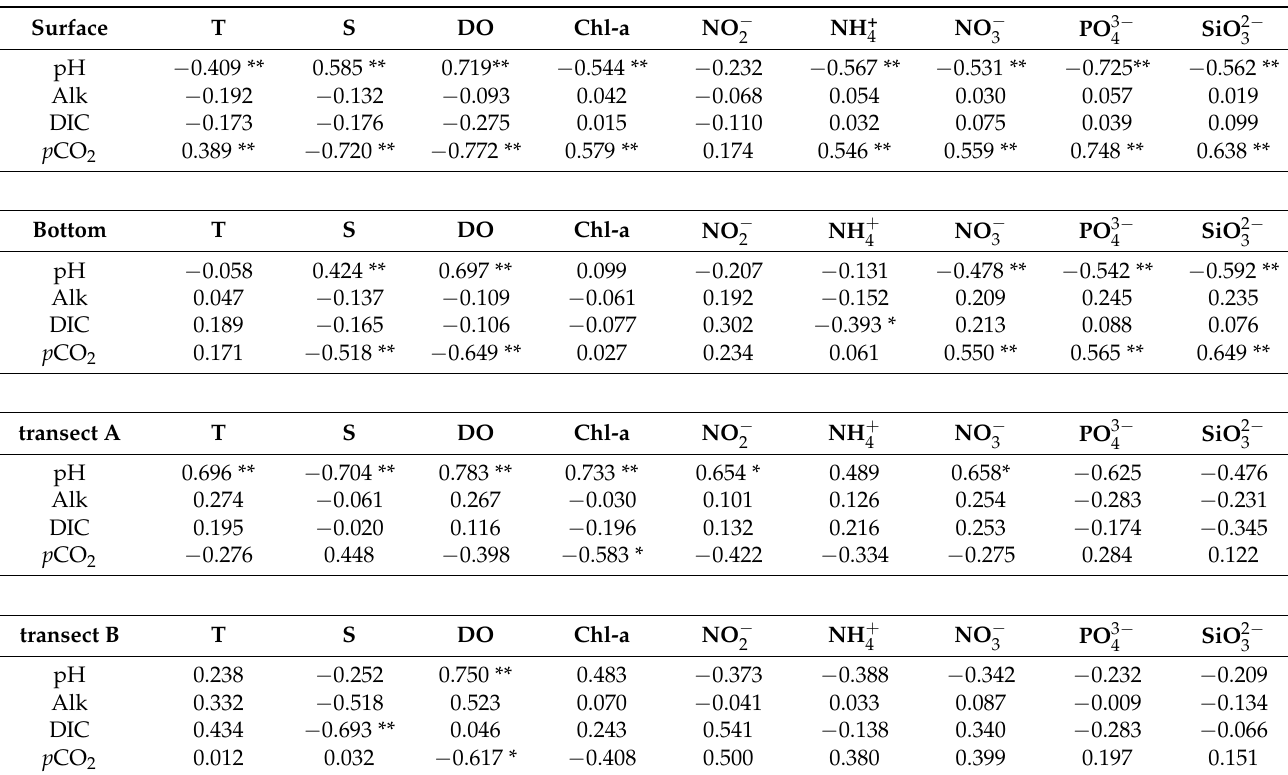
Table 5. Correlations of relevant hydrological and biochemical parameters with those of the carbonate